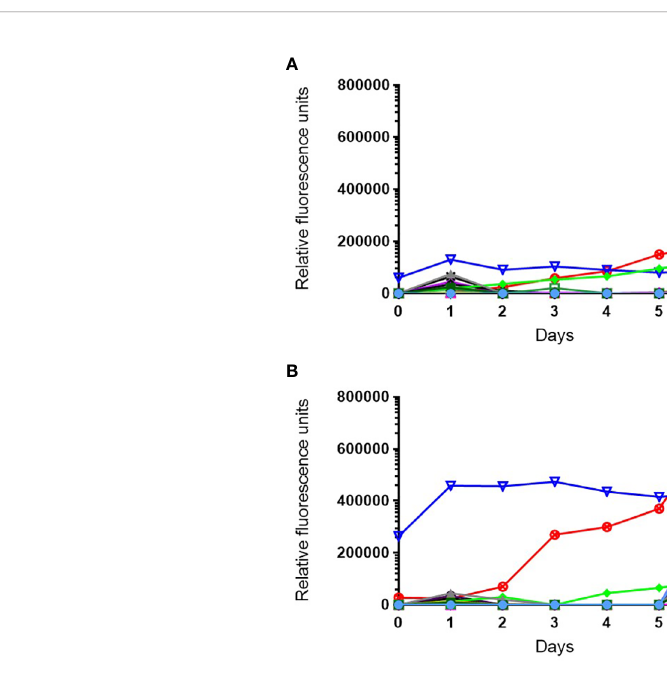
FIGURE 3 | Measurement of released GFP in culture supernatant following exposure of H37Rv - GFP strain to 1× (A) or 10× (B) MIC of the respective compound. Note 127-18 is an intrinsically fl uorescent